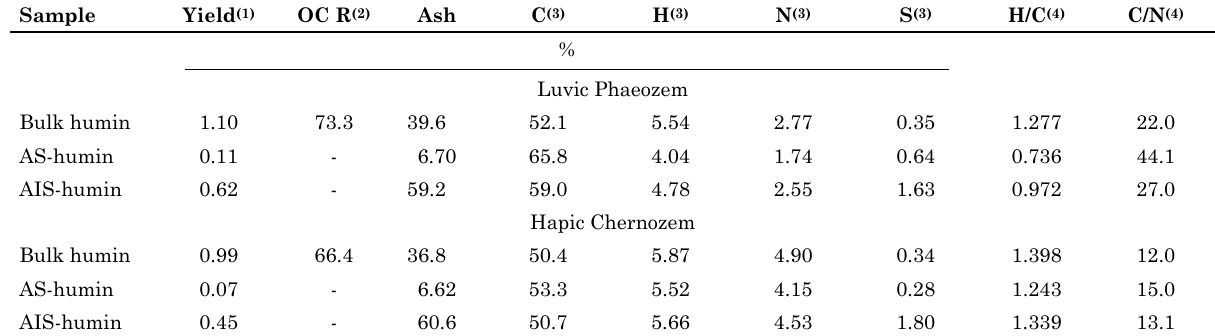
table 2. extraction yields, organic carbon (oC) recovery rates, ash contents, and elemental composition of bulk humin and its corresponding alkaline-soluble humin (as-humin) and alkaline-insoluble humin (ais-humin) from luvic Phaeozem and hapic Chernozem sample